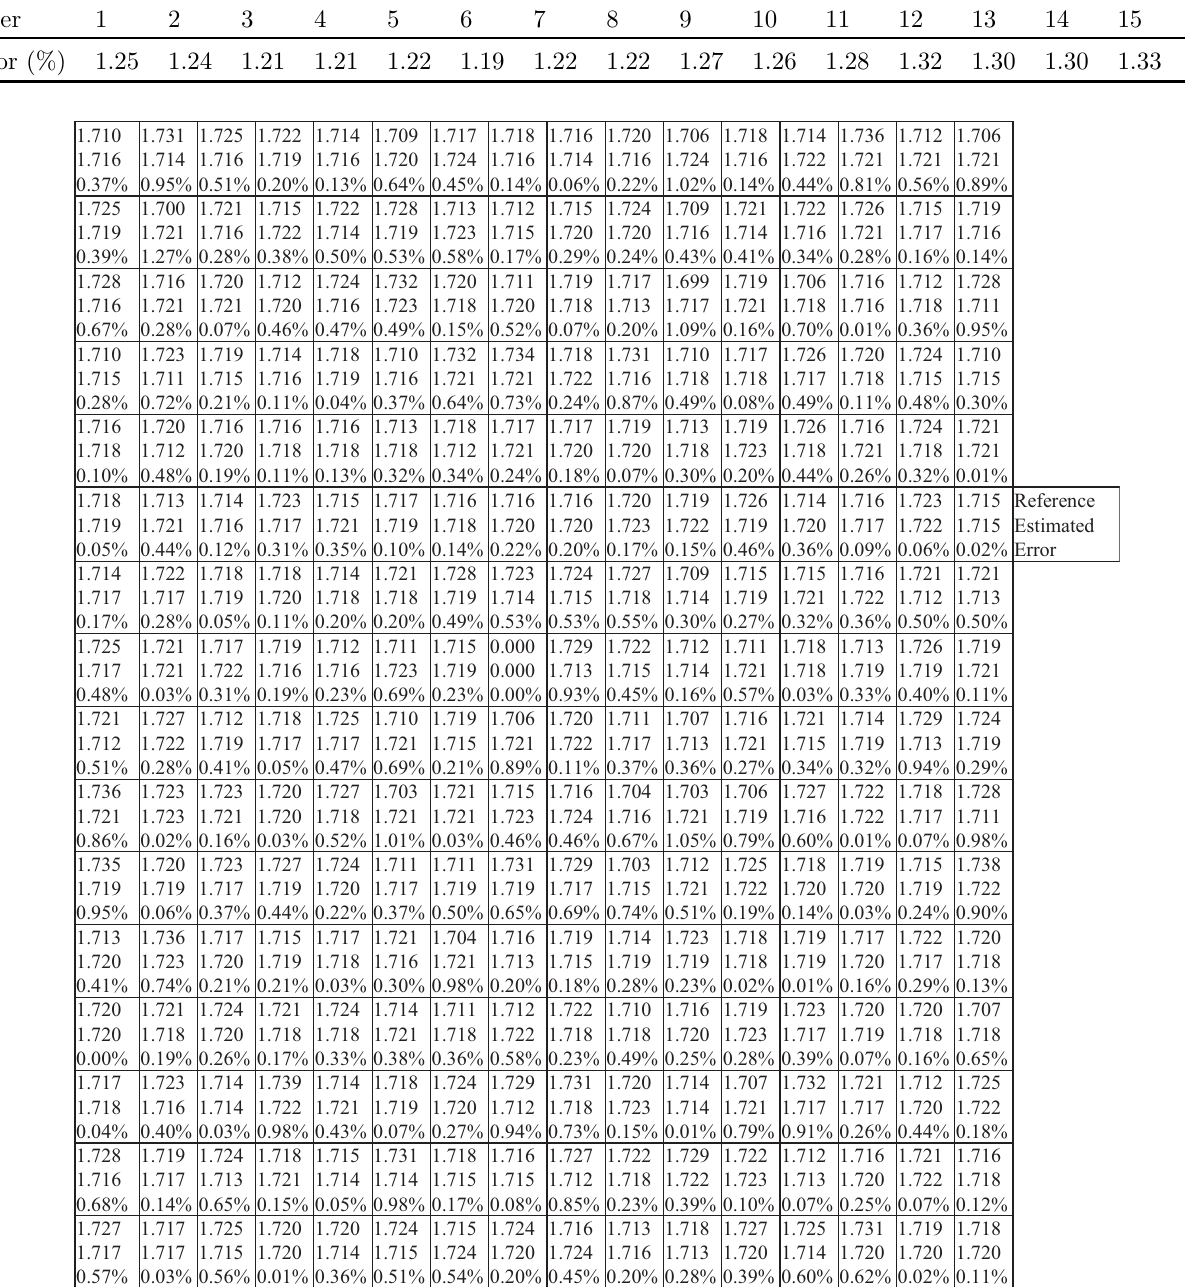
Fig. 8. Ratios between maximum and average values of the pin to pin fl uxes for assembly